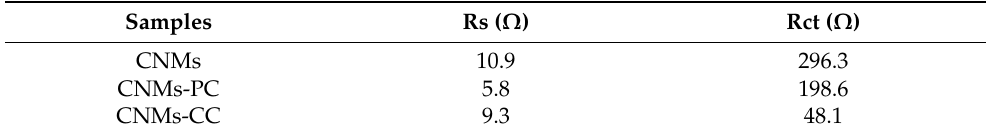
Table 3. The parameters by fitting EIS spectra of